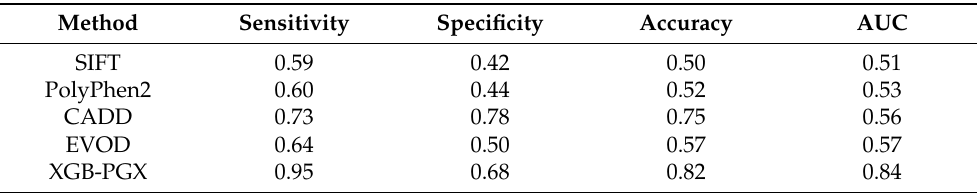
Table 5. PGx prediction performance comparison of in silico approaches.